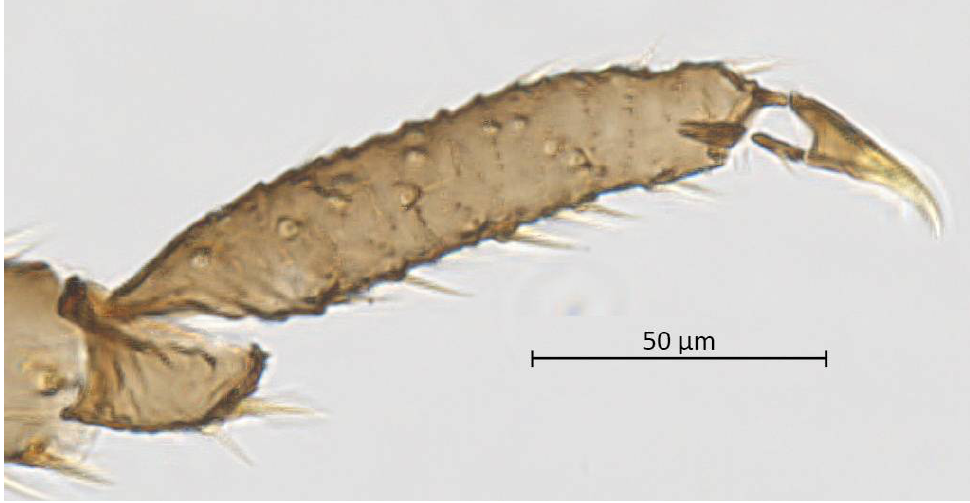
Figure 8. Hind tarsus of alate vivipara of Qiao jinshaensis sp. nov. (QMOR66209). Abdomen. Marginal and spinal wax glands (Figure 9). Cauda semicircular, length 0.35–0.57 × its BW, bearing three to four setae. Genital plate bearing 24–33 setae, mostly dis- tributed on the apical margin. Spiracles inconspicuous. Siphunculi absent. Measurements presented in Table 3.